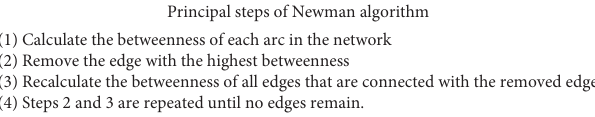
Figure 12: Steps of Newman